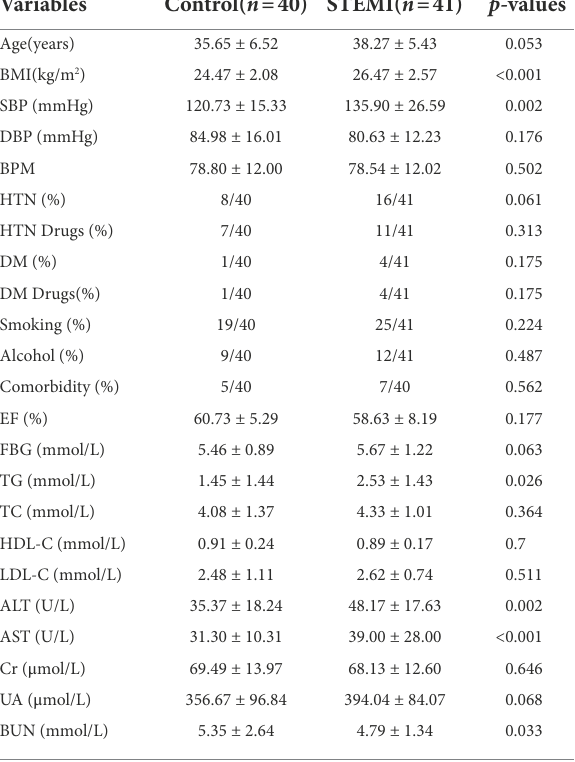
TABLE 1 Demographic and clinical characteristics of the control and STEMI